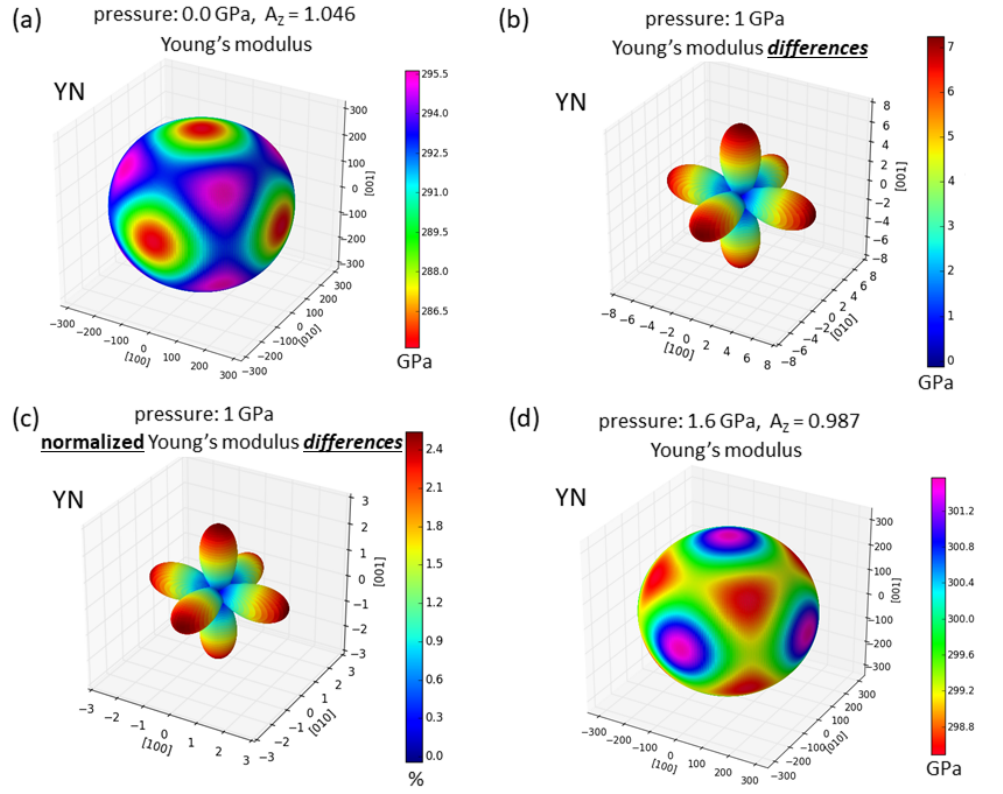
Figure 2. Computedchangesintheelasticityofrock-saltstructureYNvisualizedasdirectionaldependencies of the Young’s modulus. The zero-pressure case based on the second-order elastic constants computed by the stress-strain method is shown in part ( a ). The estimated changes in the Young’s modulus due to 1 GPa of hydrostatic pressure are shown for different directions in absolute terms (in GPa) in part ( b ) and relatively (divided by the value for this direction in the zero-pressure case) in part ( c ). The visualized changes (in the second-order elasticity at the hydrostatic pressure of 1 GPa) are predicted using the second-order and third-order elastic constants computed for the zero-pressure state according to Equations (1)–(3). Finally, the directional dependence of the second-order elasticity computed at the 1.6 GPa is shown in part ( d ). Mind the change in the scale between the parts ( a ) and ( d